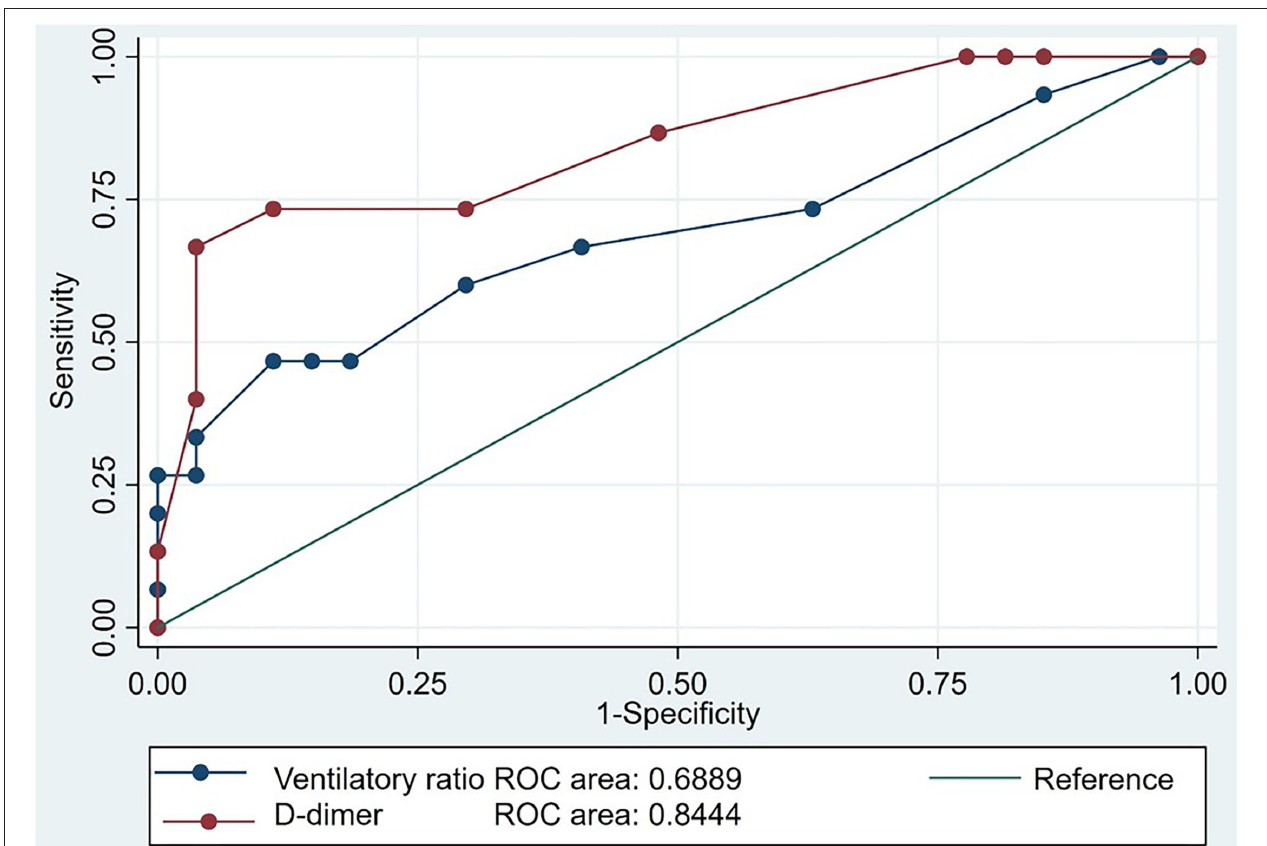
FIGURE 2 | Receiver operator characteristic curve assessing the performance of the ventilatory ratio (VR) and D-dimer in predicting the development of pulmonary embolism in 42 patients with COVID-19 associated acute respiratory distress syndrome. The predictive value of D-dimer was significantly improved over that of the VR when comparing areas under the receiver operator curve (ROC) P =